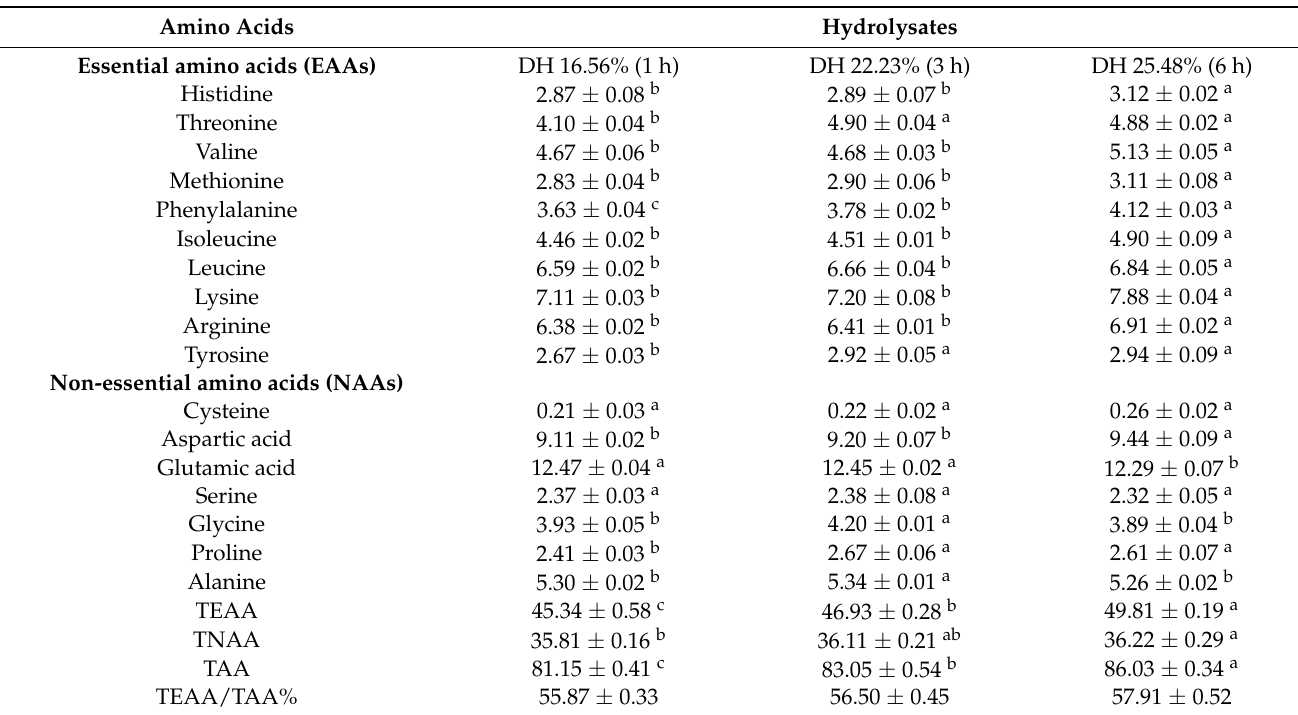
Table 3. Amino acid composition of bighead carp protein hydrolysates (g/100 g protein) obtained using the flavourzyme enzyme under optimum hydrolysis